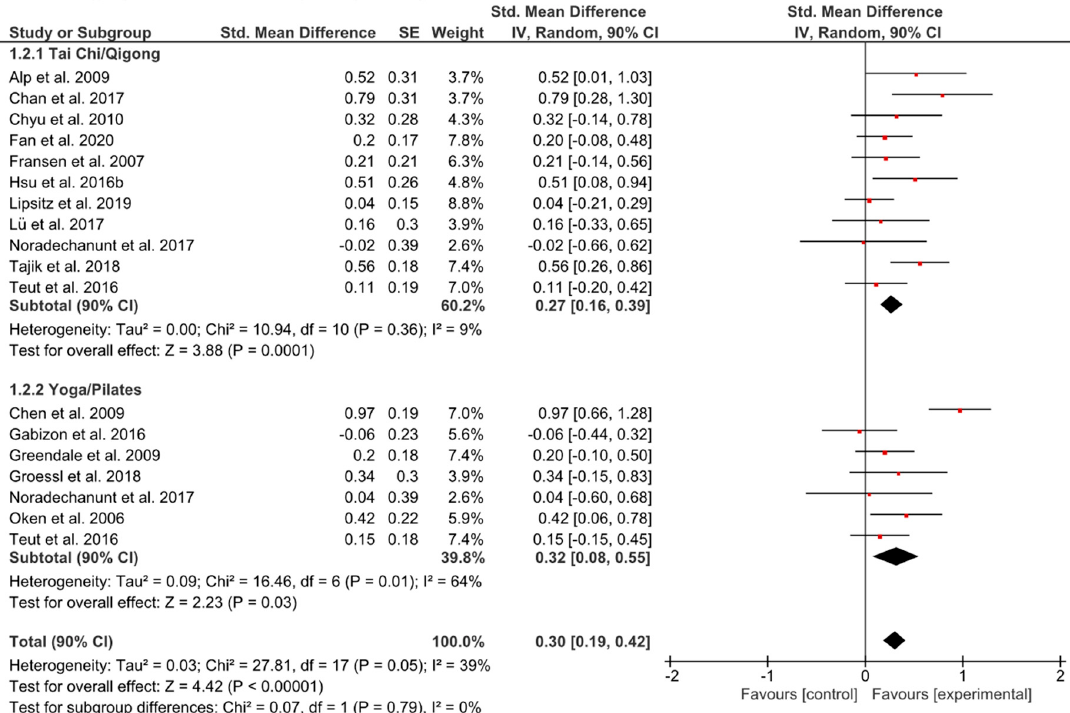
Figure 3. Standardized mean effects of mind–body interventions on physical functioning (subscale of quality of life) compared to a non-exercise control group. Data are separately presented for Tai Chi / Qigong and Yoga / Pilates. SE: standard error; IV: inverse variance model; CI: confidence interval; Std.: standardized.